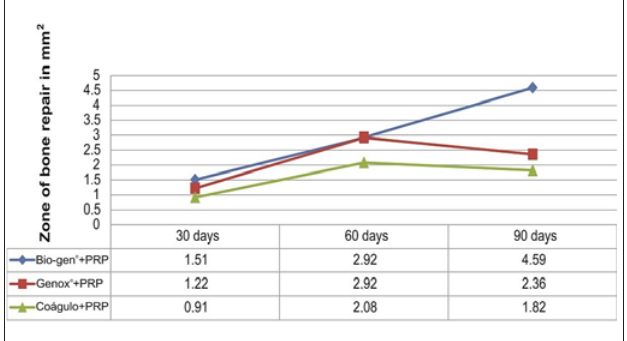
Fig. 3. Mean area of bone formation (mm 2 ) at 30, 60 and 90 days in the alveoli of clot + PRP, Genox ® + PRP and Bio-gen ® + PRP groups.